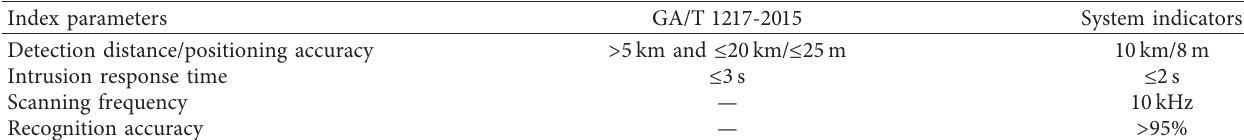
Figure 2: Block diagram of the fiber vibration detection system based on Φ -OTDR. Table 1: Technical specifications of the distributed fiber perimeter security system based on Φ -OTDR.